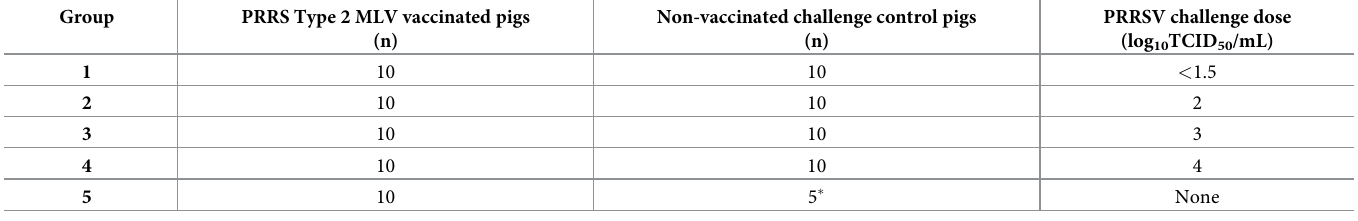
Table 1. Study design for a randomised, blinded, vaccination-challenge